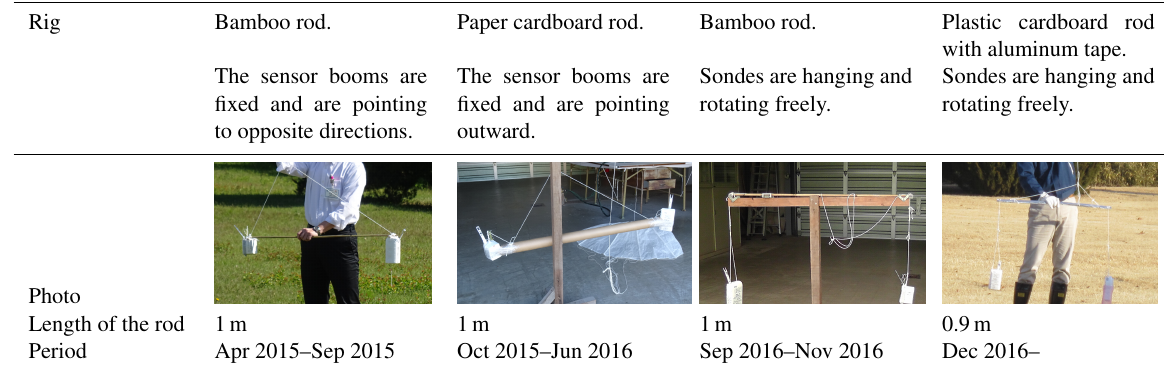
Table 3. Rig configurations adopted for dual observation. Rig Bamboo rod. Paper cardboard rod. Bamboo rod. Plastic cardboard rod with aluminum tape. Sondes are hanging and Sondes are hanging and The sensor booms are The sensor booms are rotating freely. rotating freely. fixed and are pointing fixed and are pointing outward. to opposite directions.